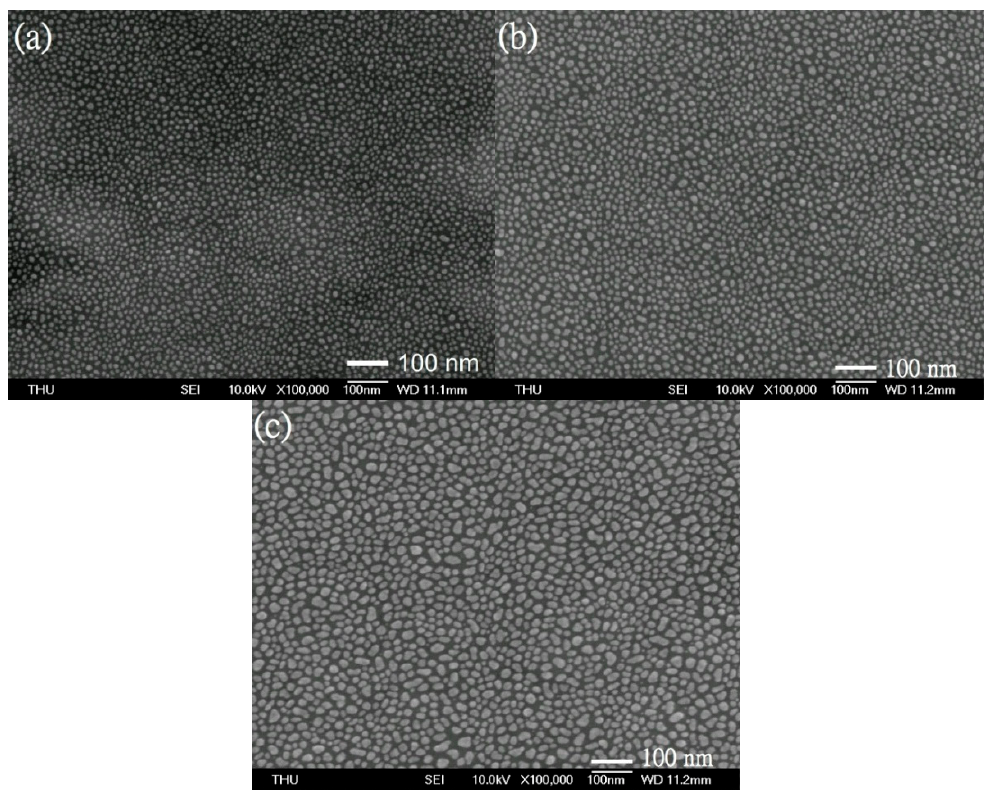
Figure 3. The scanning electron microscopy (SEM) images of the surface morphology of the silver nano-particles (Ag-NPS) layer on the poly-Si films after ( a ) 5, ( b ) 7.5, and ( c ) 10 min thermal evaporation with very low deposition rate of 0.4 nm/min. The Ag-NPS size increases with longer deposition time, and the particle surface density reduces, in the Ag-NPS layer.